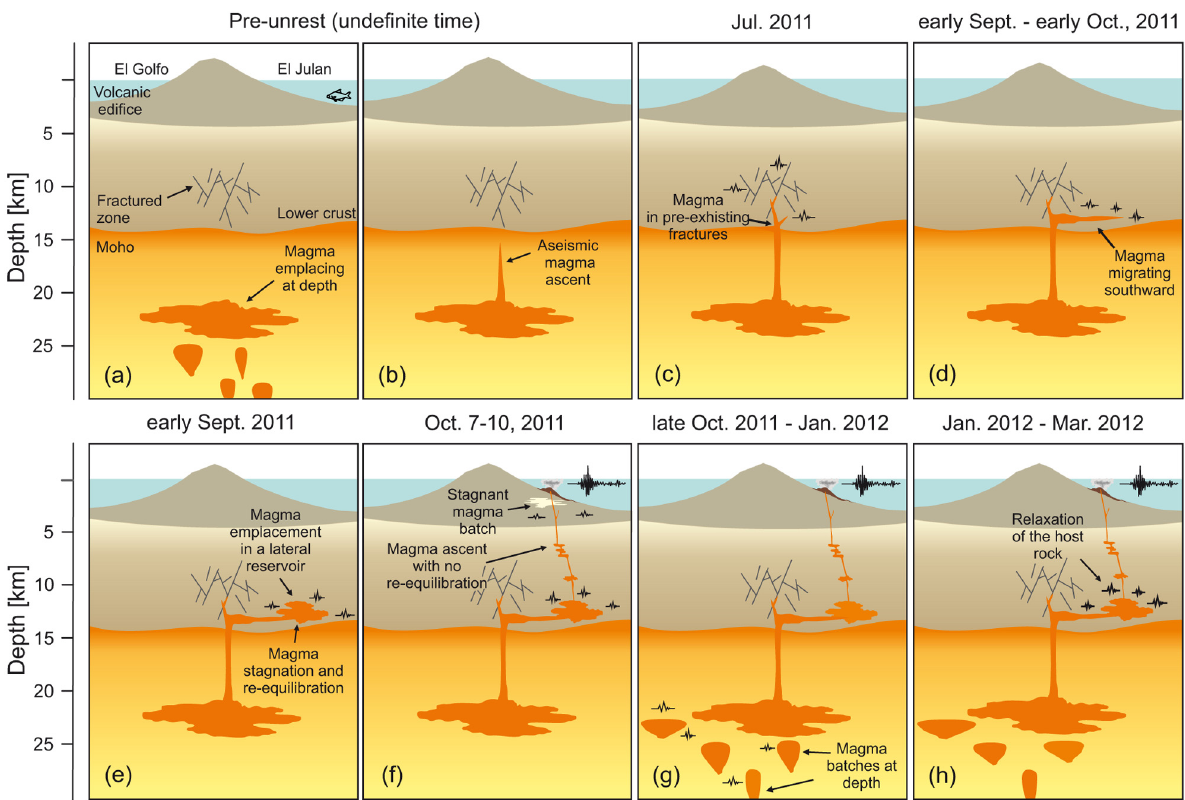
Figure 13. Cartoon interpretation (not to scale) of the volcanic system activated in El Hierro Island during the 2011-2012 unrest and erup- tion (along a north-south cross section). Panels (a-h) show in brief the main events that led to the eruption that were discussed in the